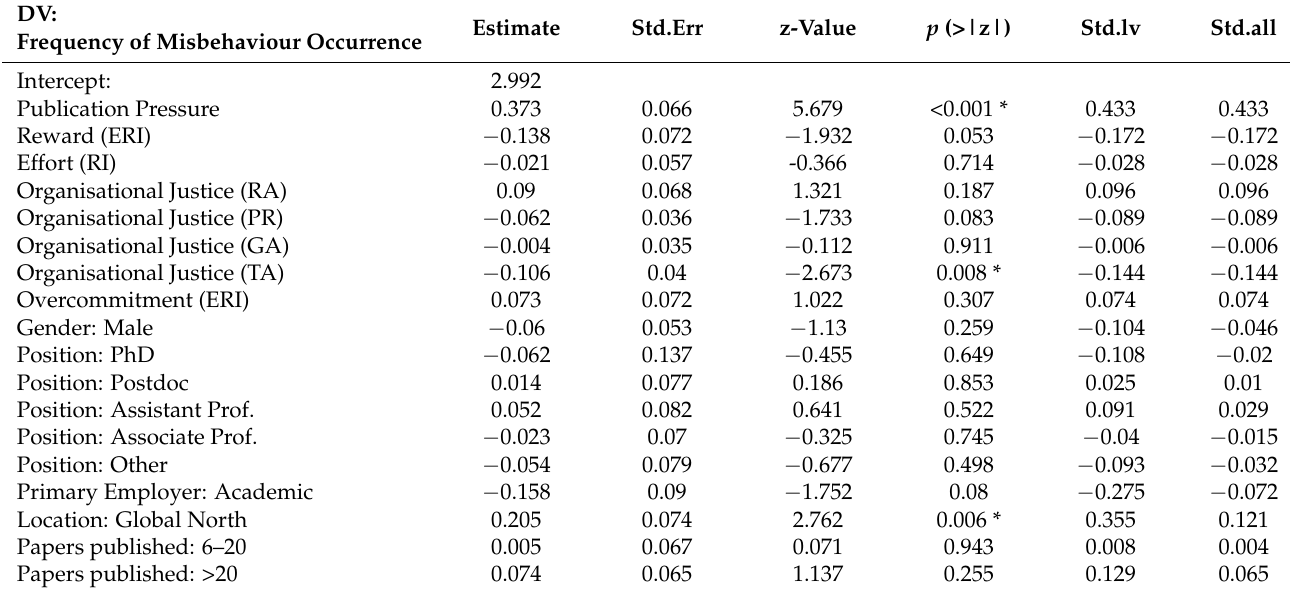
Table 7. Extracted output for the dependent variable “Frequency of Misbehaviour Occurrence” from the regression analysis of our SEM model. * indicates statistical significance ( p <